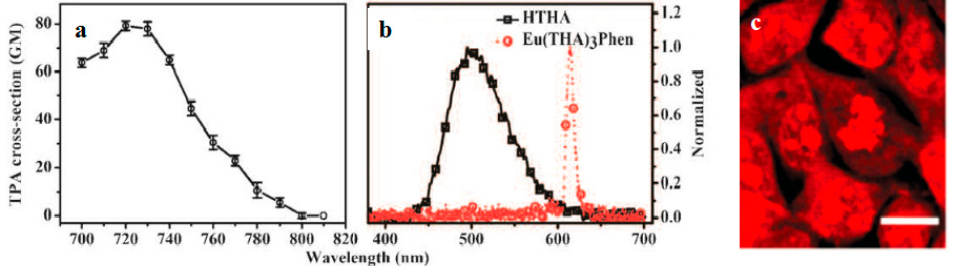
Figure 12. ( a ) 2PA cross sections ( δ ) for Eu(THA) 3 Phen ( 54 ); ( b ) Two-photon-excited fluorescence (2PEF) of HTHA and Eu(THA) 3 Phen ( 54 ) in DCM (1 × 10 − 3 mol·L − 1 ); ( c ) Live cellular image based on